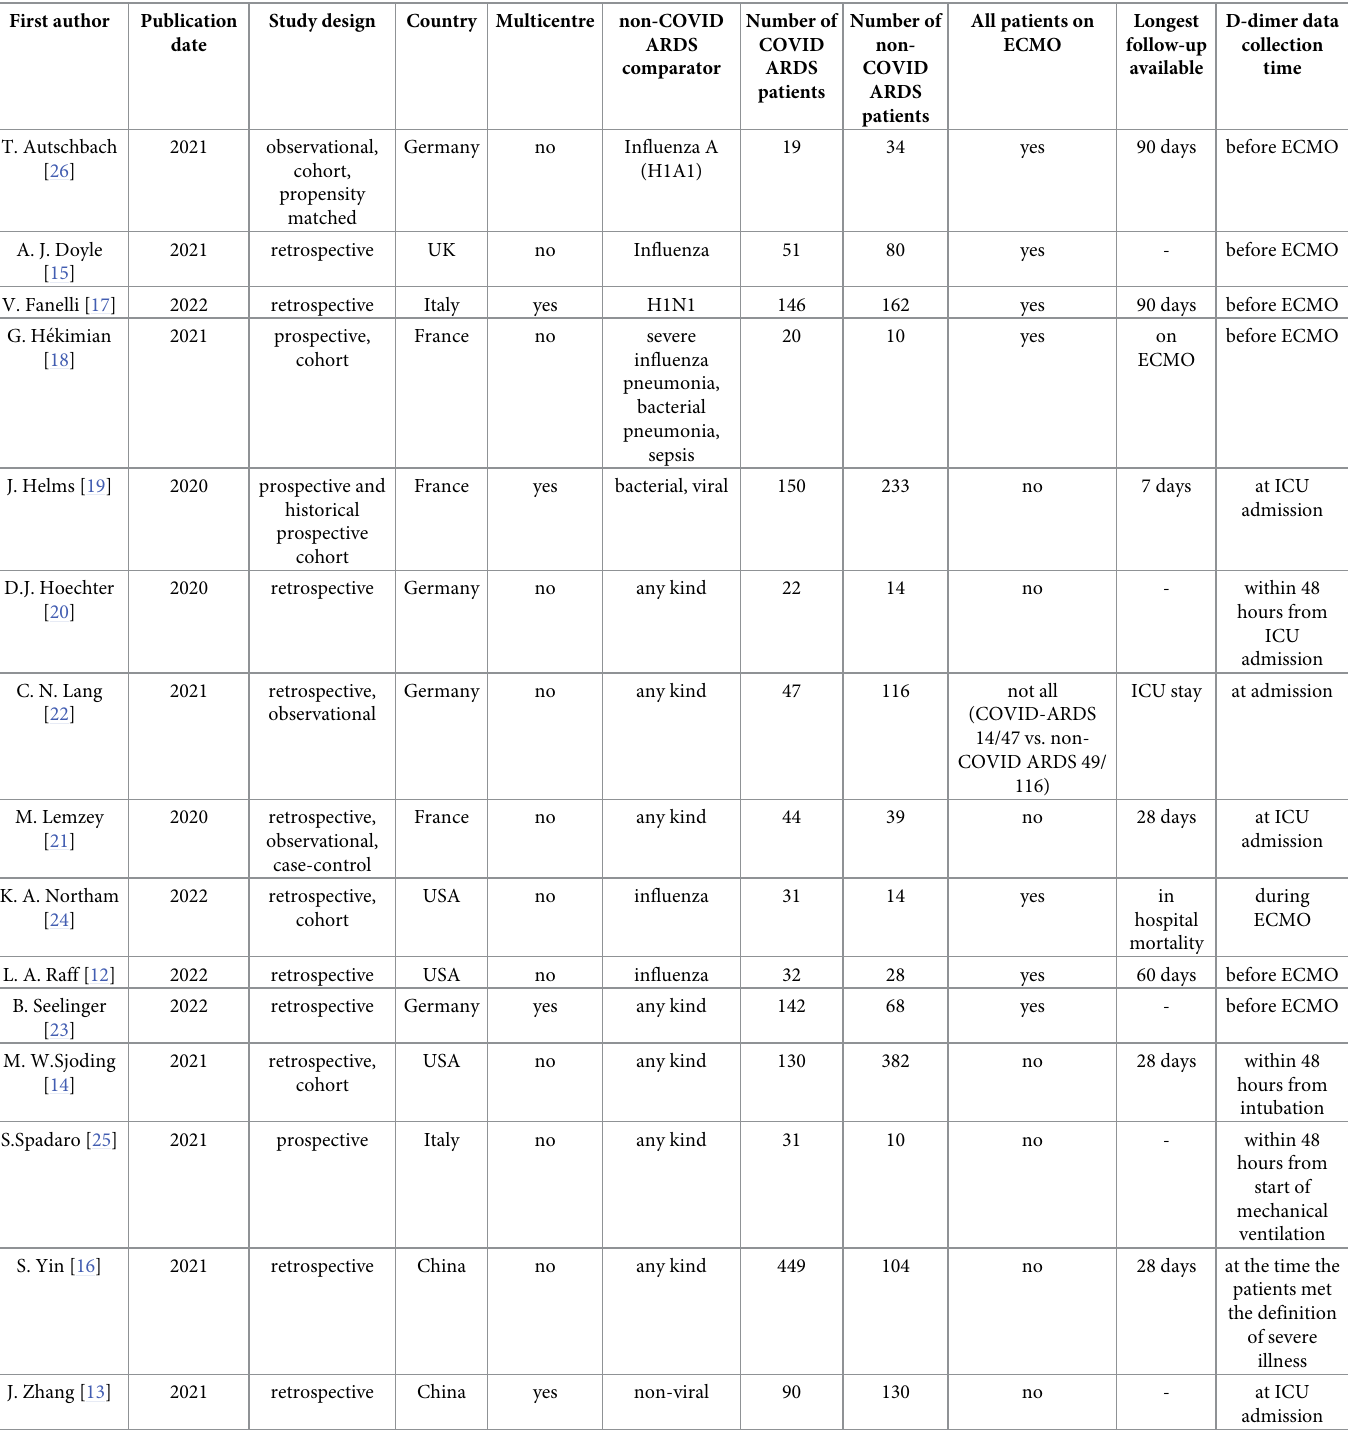
Table 1. Characteristics of included